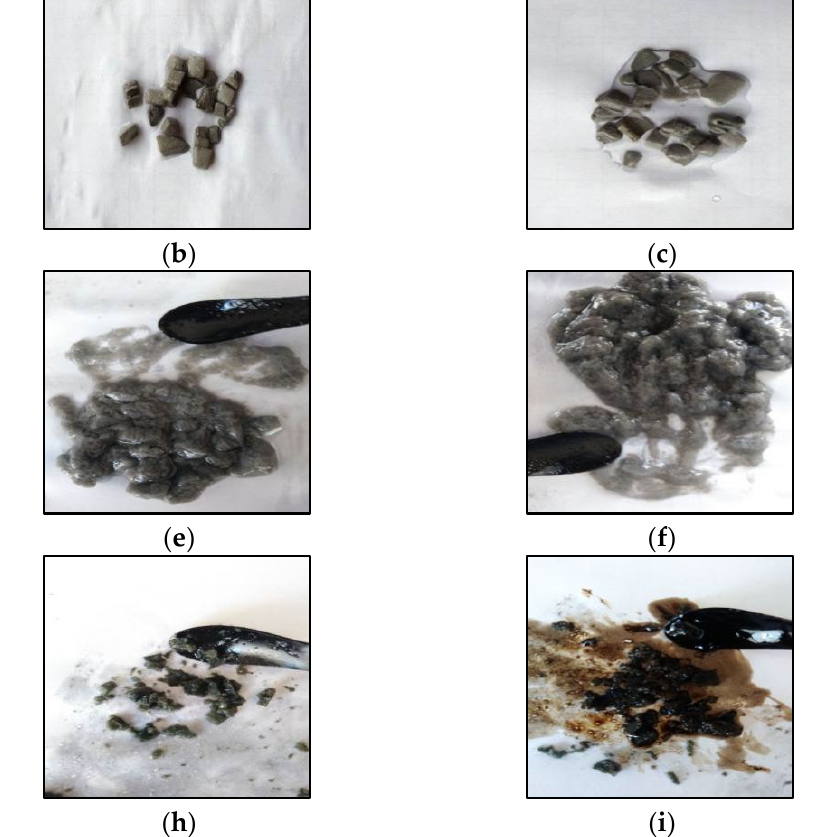
Figure 10. Morphological diagram of particles before and after immersion in different environ- ments. ( a ) Unsaturated water swelling rubber particles, ( b ) After immersion in clean water for 90 days, ( c ) After sewage soaking for 90 days, ( d ) After soaking in NaOH solution for 90 days, ( e ) After immersion in NaCO3 solution for 90 days, ( f ) After soaking in NaHCO3 solution for 90 days, ( g ) After diesel oil soaking for 90 days, ( h ) After soaking in kerosene for 90 days, ( i ) After 90 days of crude oil immersion.